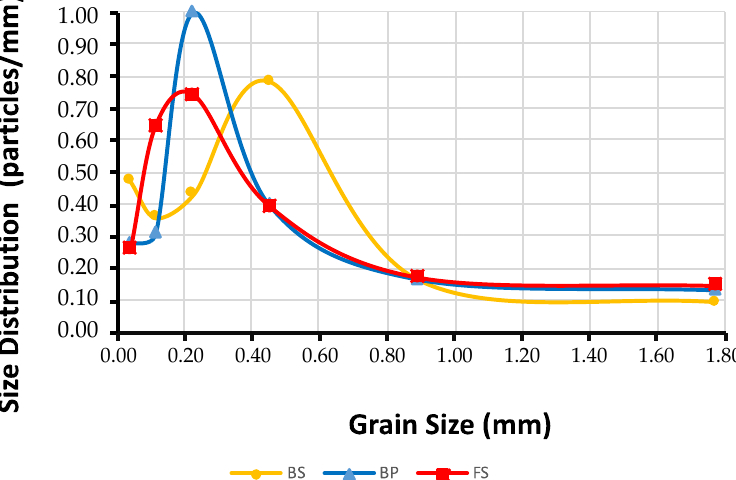
Figure 3. Normalized size distribution of the three sands.